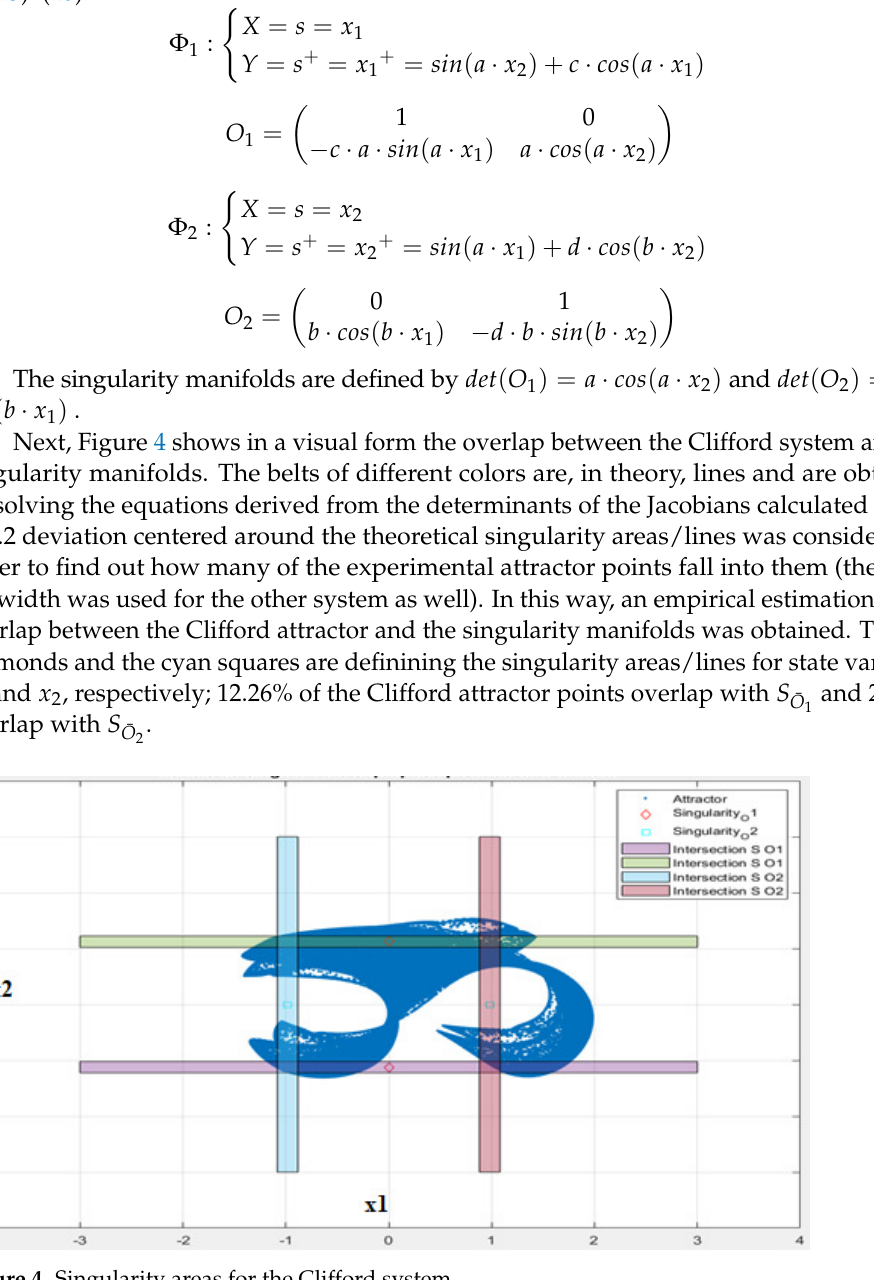
Figure 4. Singularity areas for the Clifford